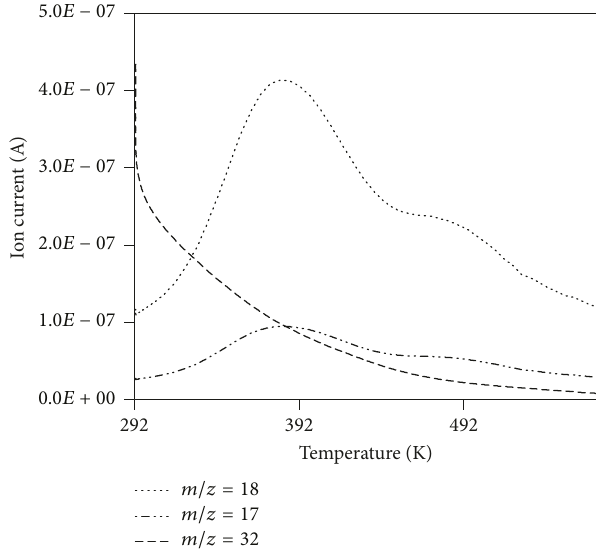
Figure 5: TG-MS profiles of lactic